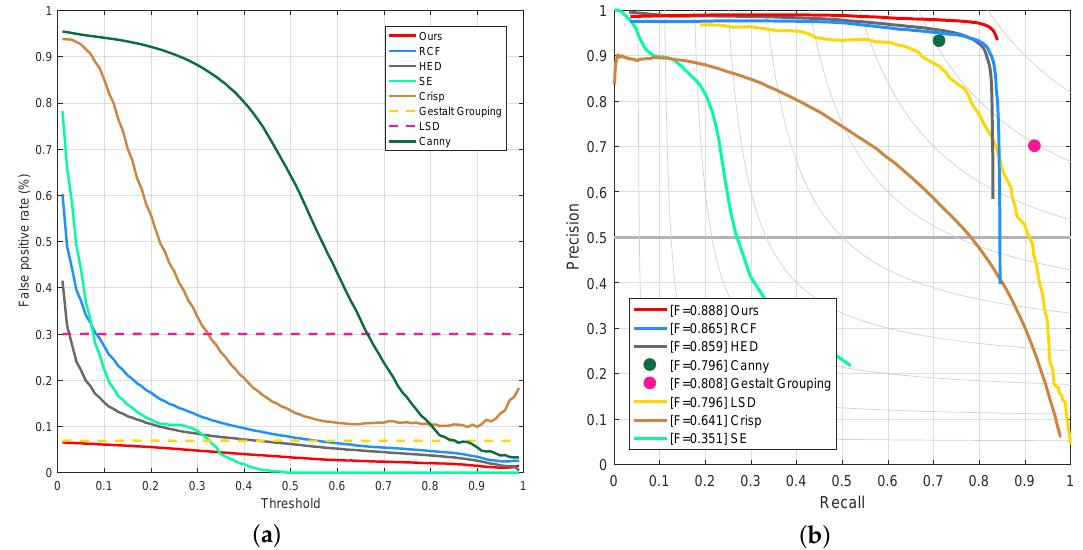
Figure 8. The evaluation results on PLDM dataset. Our proposed method achieves superior F 1 -measure (ODS = 0.888) compared with baselines. ( a ) The false positive rate curves at different thresholds on PLDM dataset; ( b ) The precision-recall curves on PLDM dataset.